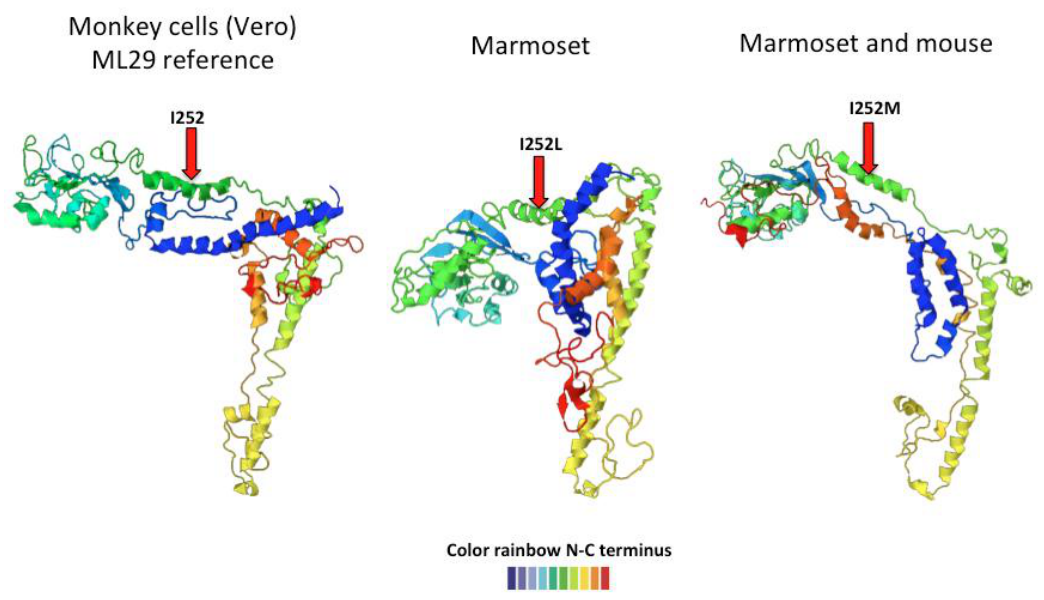
Figure 4. Predicted ML29 host-specific changes in GPC. The left-most structure shows the ML29 GPC predicted structure after passage in Vero cells. After inoculation into marmosets, the recovered viruses showed an isoleucine (I) to leucine (L) change at position 252 that affects the predicted GPC structure (middle structure). Another mutation at the same position, I to M, also changed GPC structure (figure on the right). The structure goes from N-terminus (blue) to C-terminus